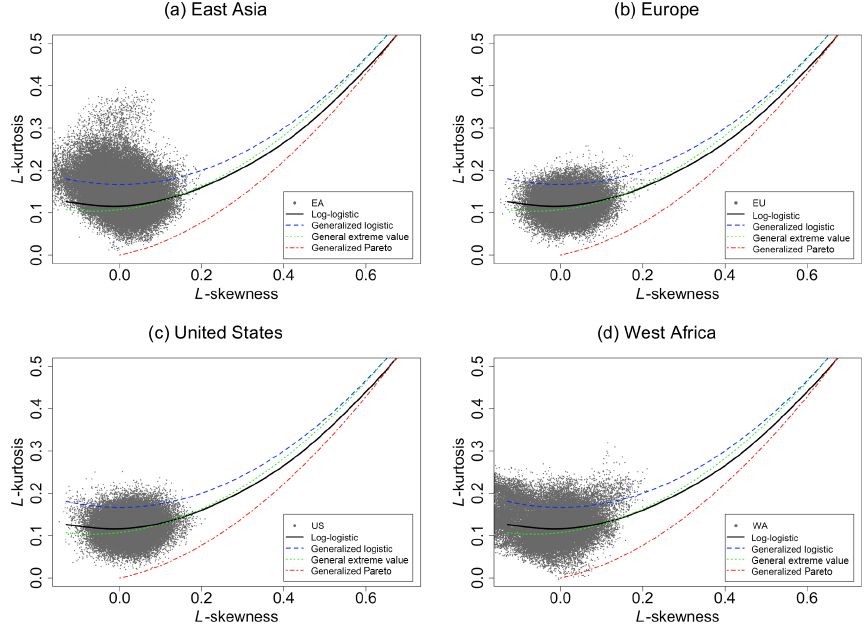
Figure 5. L -moment ratio diagrams for the annual surplus or deficit ( D ) in Eq. (1) with a 12-month timescale based on CRU for each region from 1901–2014 and 1901–1957.